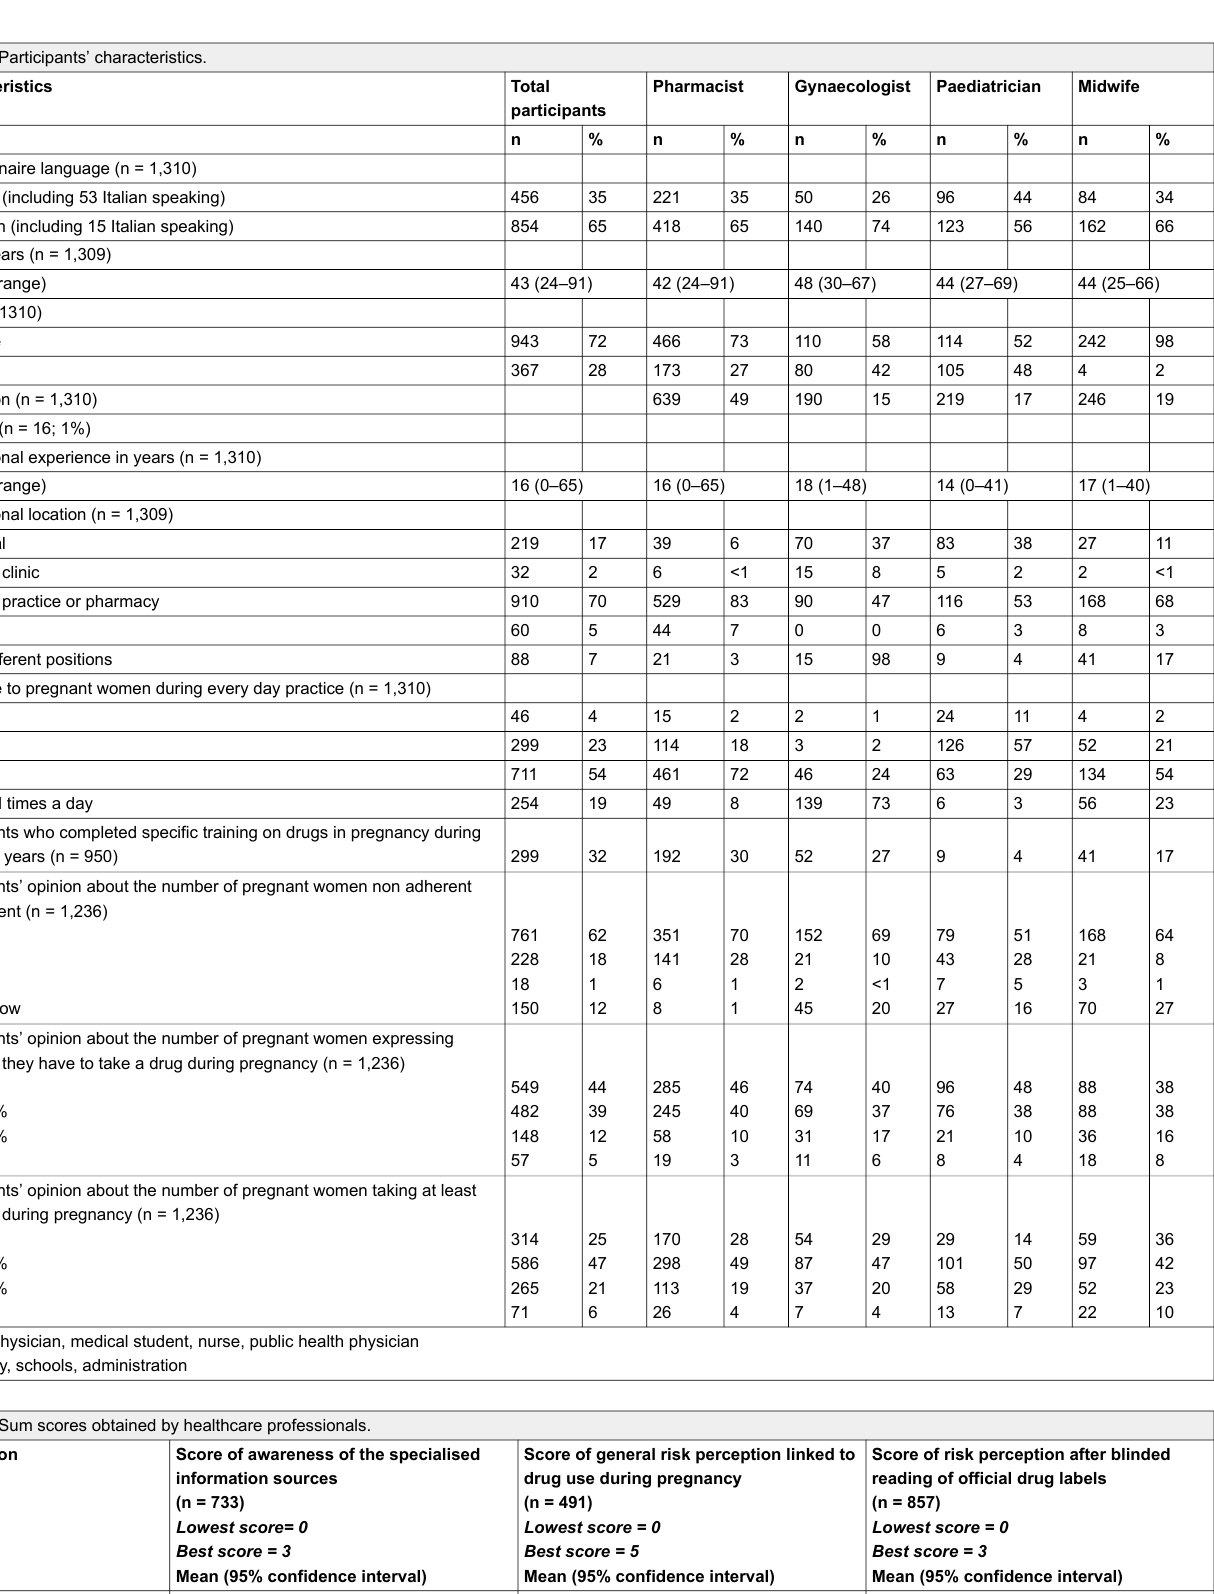
Table 3: Participants’ characteristics.